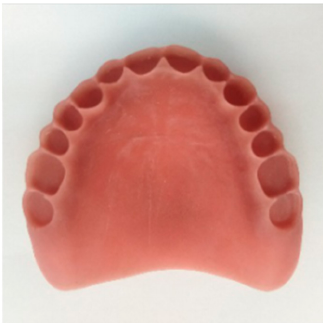
Figure 8. 3D printed denture base using composite PMMA containing 1 wt.% CNCs-Ag.